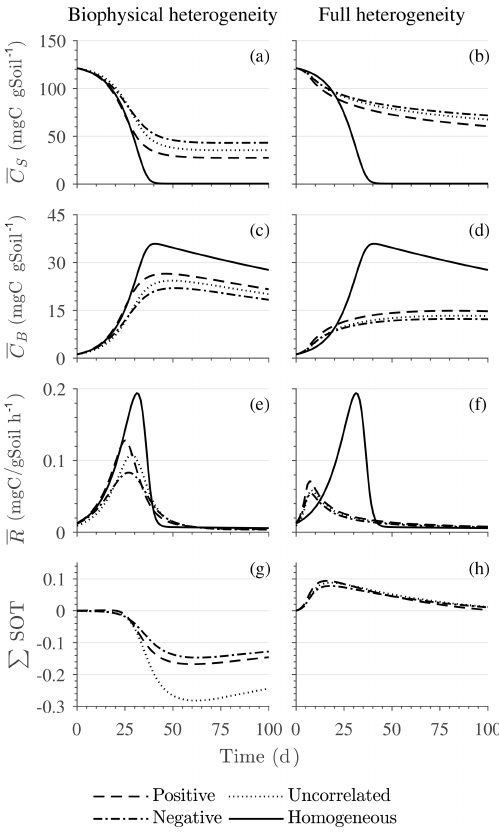
Figure 6. Scenario 2 (HS with Michaelis–Menten kinetics): effect of biophysical heterogeneity (left) and full heterogeneity (right) on the macroscopic decomposition dynamics when the substrate is dis- tributed around a value higher than the steady state of the homoge- neous system: (a, b) mean substrate C ( C s ), (c, d) mean microbial C ( C b ), (e, f) mean respiration rate ( R ), and (g, h) sum of second- order terms (cid:0)(cid:80) HOT (cid:1)